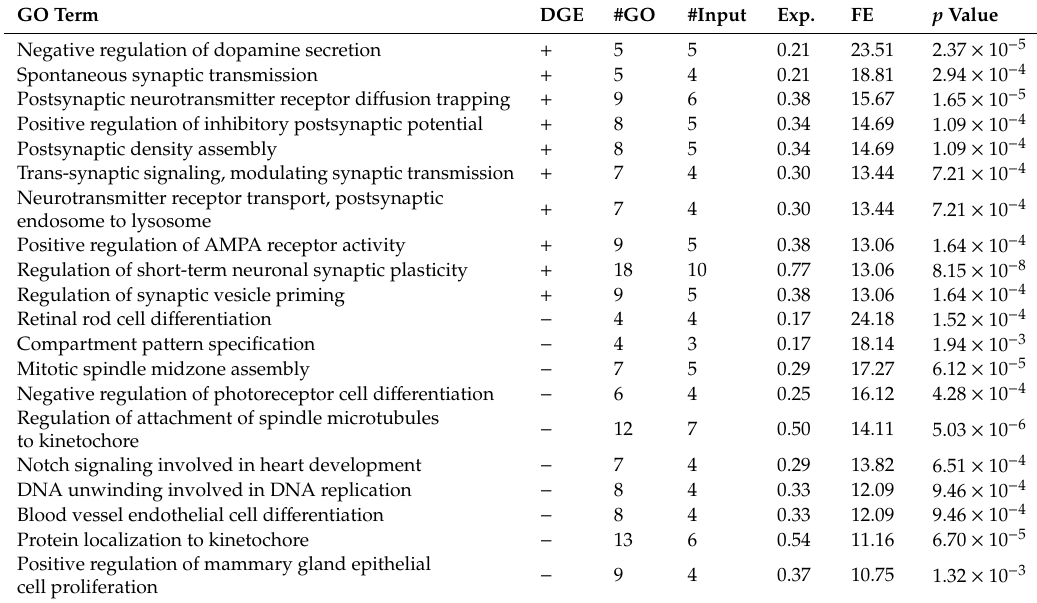
Table 2. Top 10 enriched GO terms of up- and downregulated genes in PN5 Lgr5 + cells compared to Lgr5 − . DGE: Input from up ( + ) or downregulated ( − ) genes from di ff erential gene expression; #GO: number of genes in the GO term; #Input: number of genes in the input list; Exp.: expected number of genes in the input list; FE: fold